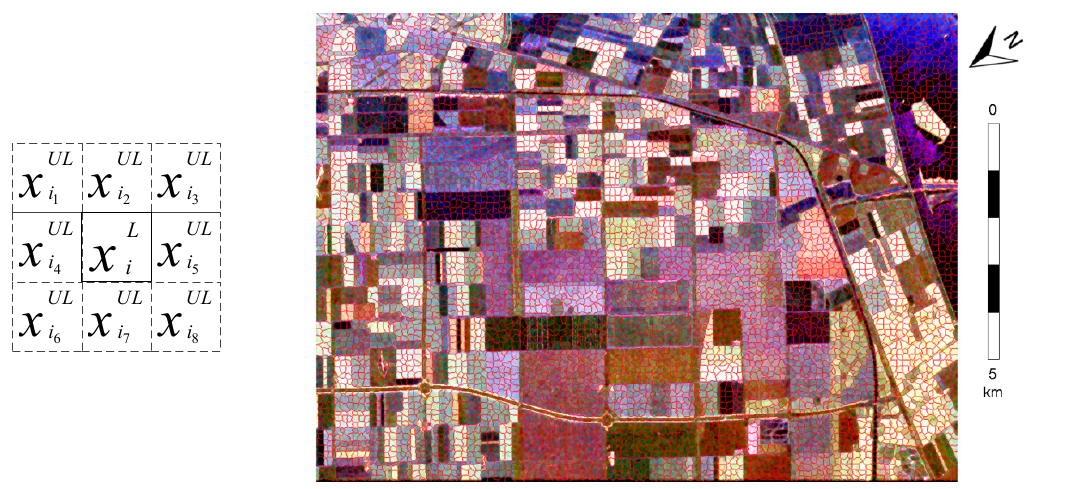
Figure 3. The contextual 8-connected pixel neighborhood ( Left ) and ( Right ) our result